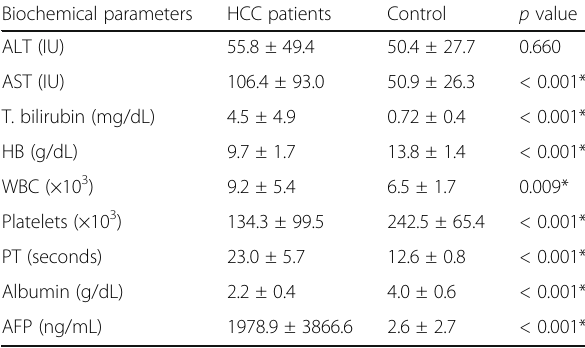
Table 2 Biochemical parameters of HCC and HCV